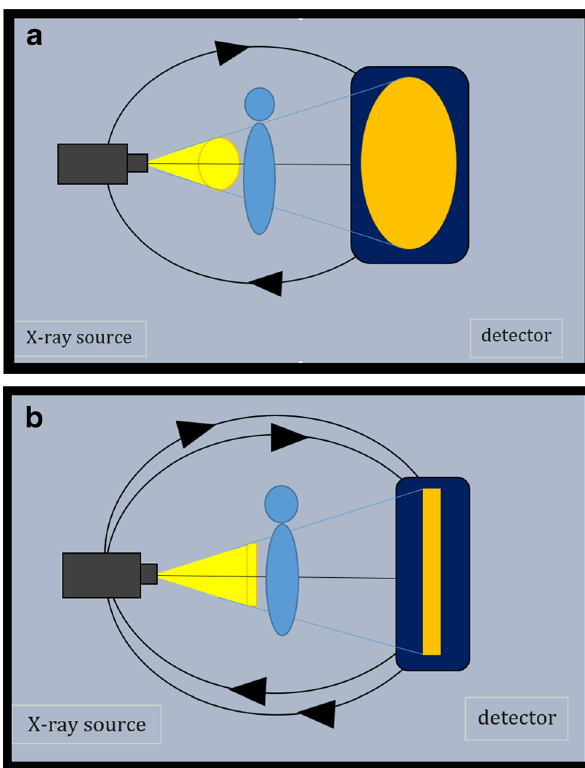
Fig. 1 Principle of CBCT and MDCT. a In CBCT, cone-shaped X-ray beam reaches a flat detectorafter a singlerotation ofthe gantry around the patient. b In MDCT, narrowly collimated, fan-shaped beam and multiple linear detectors rotate around the patient to acquire multiple image sections per rotation. In both techniques volumetric images are reconstructed into a 3-D volume dataset of images